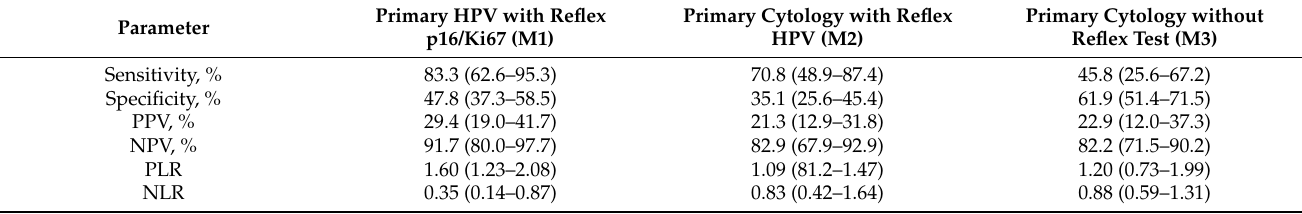
Table 11. Performance characteristics of analyzed screening models for HSIL (CIN2+) detection.